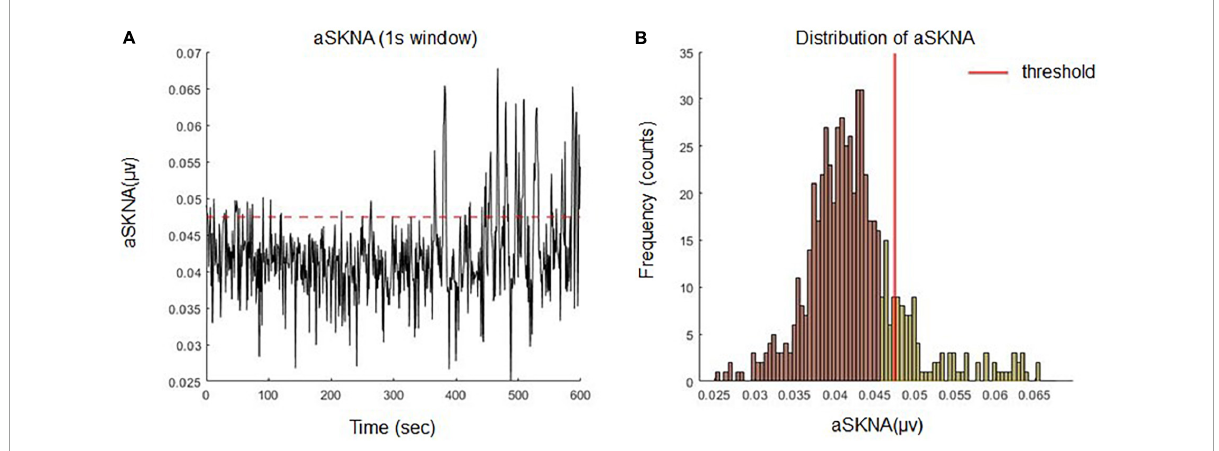
FIGURE2 (A) Definition of burst activities of aSKNA signal by an individualized threshold. (B) The amplitudes of the aSKNA signal were classified into two clusters (background noise and sympathetic nerve activity) by K means algorithm. The cutoff threshold of each subject was determined by the mean value plus three times the standard deviation of the background group and the burst activity can be viewed as the activities over background noise.